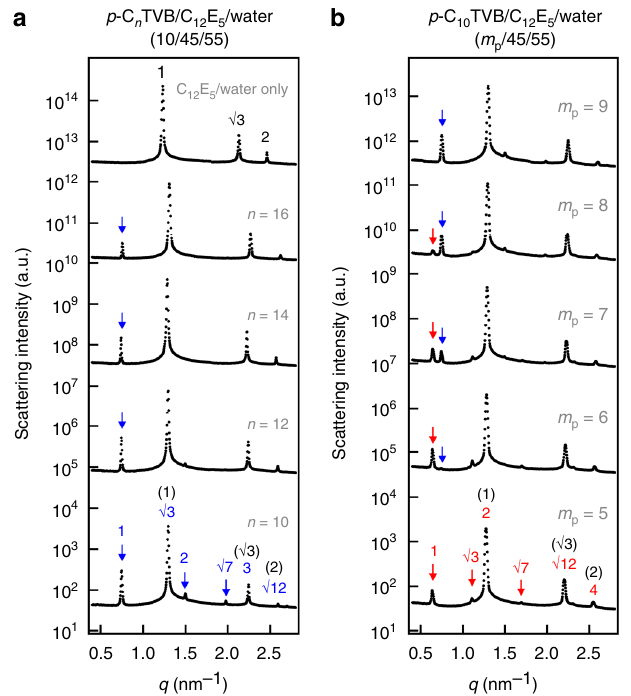
C 12 E 5 /water, a mixture of deuterated and hydrated C n TVB (1:2 by Fig. 4 Effects of diameter and mixing ratios on the binary mixtures. a SAXS intensities of p -C n TVB/C 12 E 5 /water (10/45/55) for n = 10, 12, 14, and 16 in comparison with the SAXS intensity of C 12 E 5 /water (45/55). b SAXS intensities of p -C 10 TVB/C 12 E 5 /water ( m p /45/55) at different mixing ratios ( m p = 5, 6, 7, 8, and 9). All the data were measured at 6°C. Scattering intensities are shifted vertically for visual (Fig. 4b). As the m p is decreased from 9 to 5, a new peak shows up − 1 and grows while the intensity of the peak at q = at q = 0.63 nm 0.75 nm − 1 decreases and eventually disappears. Two additional − 1 new peaks at q = 1.10 and 1.68 nm also become clear when m p is decreased to 5. It should be noted that the new peak at q = 0.63 − 1 now makes a peak position of 1:2 with the fi rst-order nm hexagonal peak of C 12 E 5 cylinders ( q = 1.27 nm − 1 ). (This is in clear contrast with the p -C 10 TVB/C 12 E 5 /water sample at m p = 10 in which the new peak at q = 0.75 nm − 1 makes a peak position ratio of 1: √ 3 with the fi rst-order hexagonal peak of C 12 E 5 cylinders.) All the SAXS peaks of the p -C 10 TVB/C 12 E 5 /water at m p = 5 can be indexed by two sets of the same peak position ratio of 1: √ 3:2: √ 7:3: √ 12, which are directly coupled each other with a scaling of 1:2 (indicated by the red and black numbers). This indicates that a discrete structural transition from a hierarchically coupled hexagonal arrays with a scaling of 1: √ 3 to that with a scaling of 1:2 occurs as the concentration of p -C 10 TVB is decreased from m p = 10 to m p = 5.